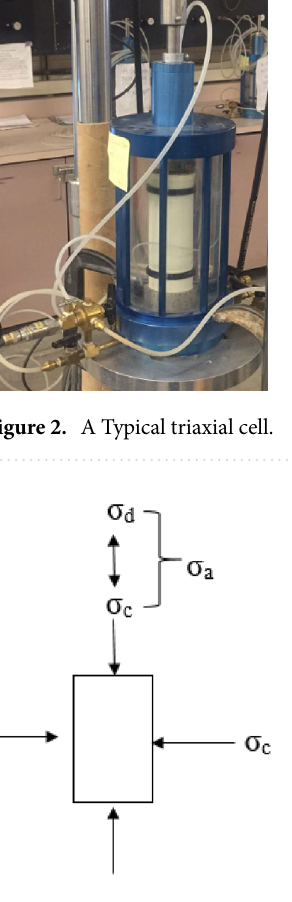
Figure 3. Triaxial stresses.